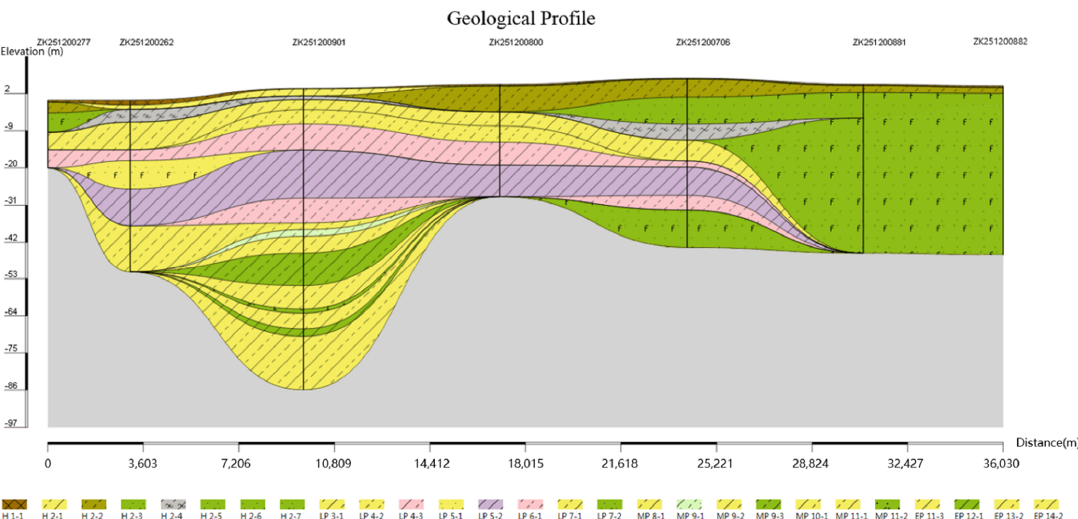
Figure 15. Geological profile VIII corresponding to drilling line VIII in Figure 12 by unique path method.